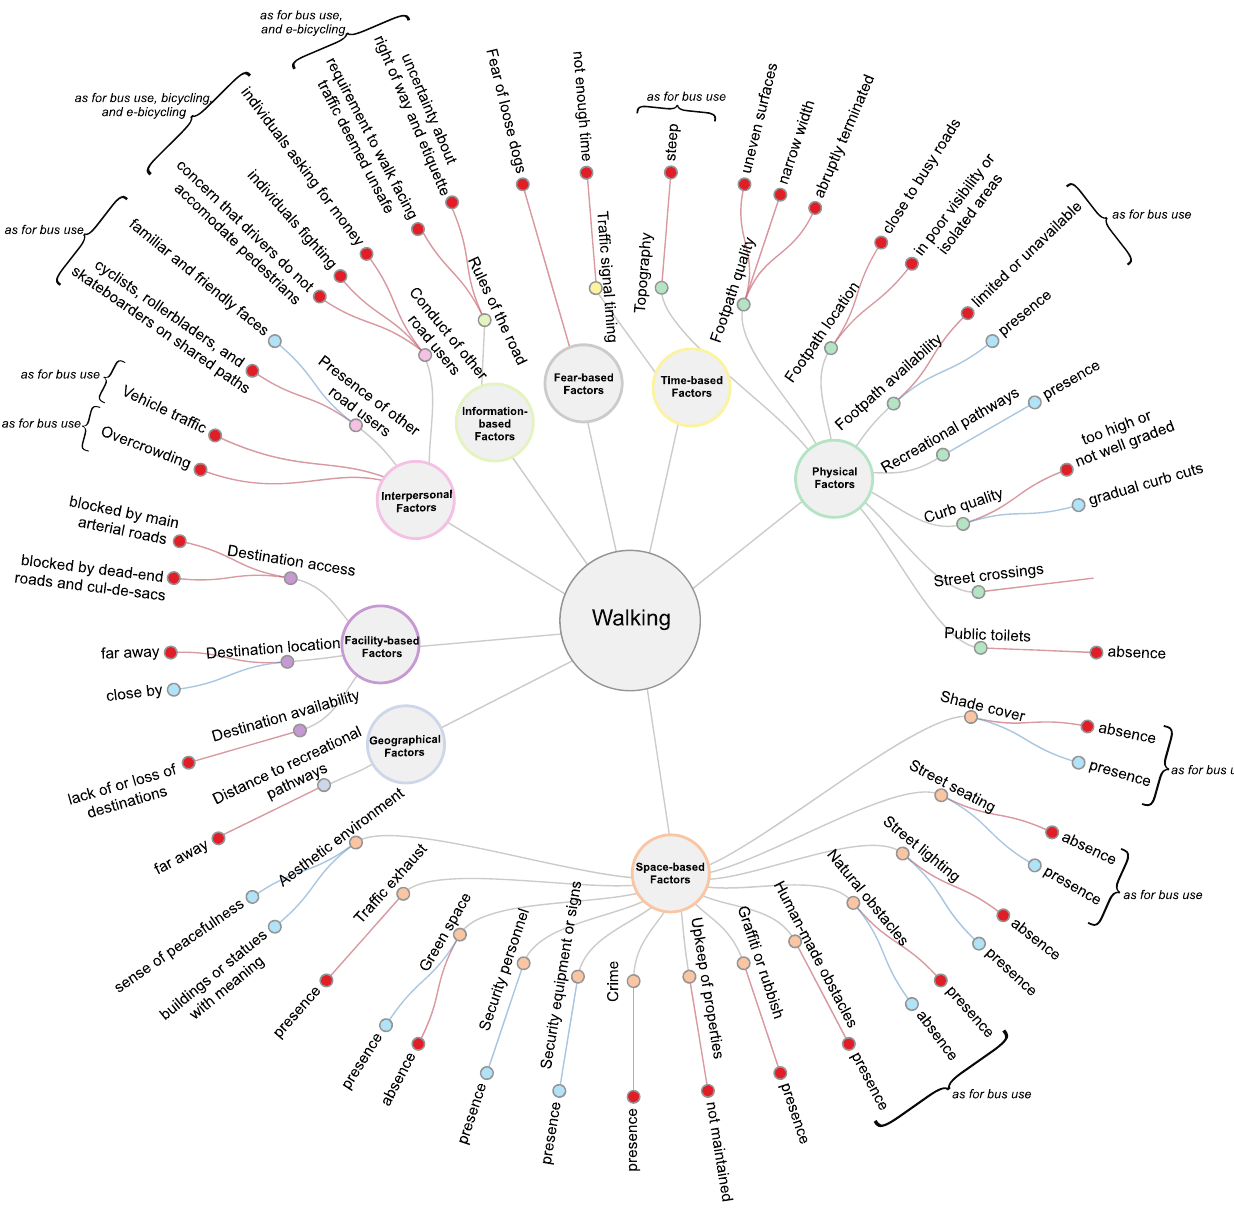
Figure A1. Radial dendrogram depicting the influences on older people’s walking, as derived from 10 articles.